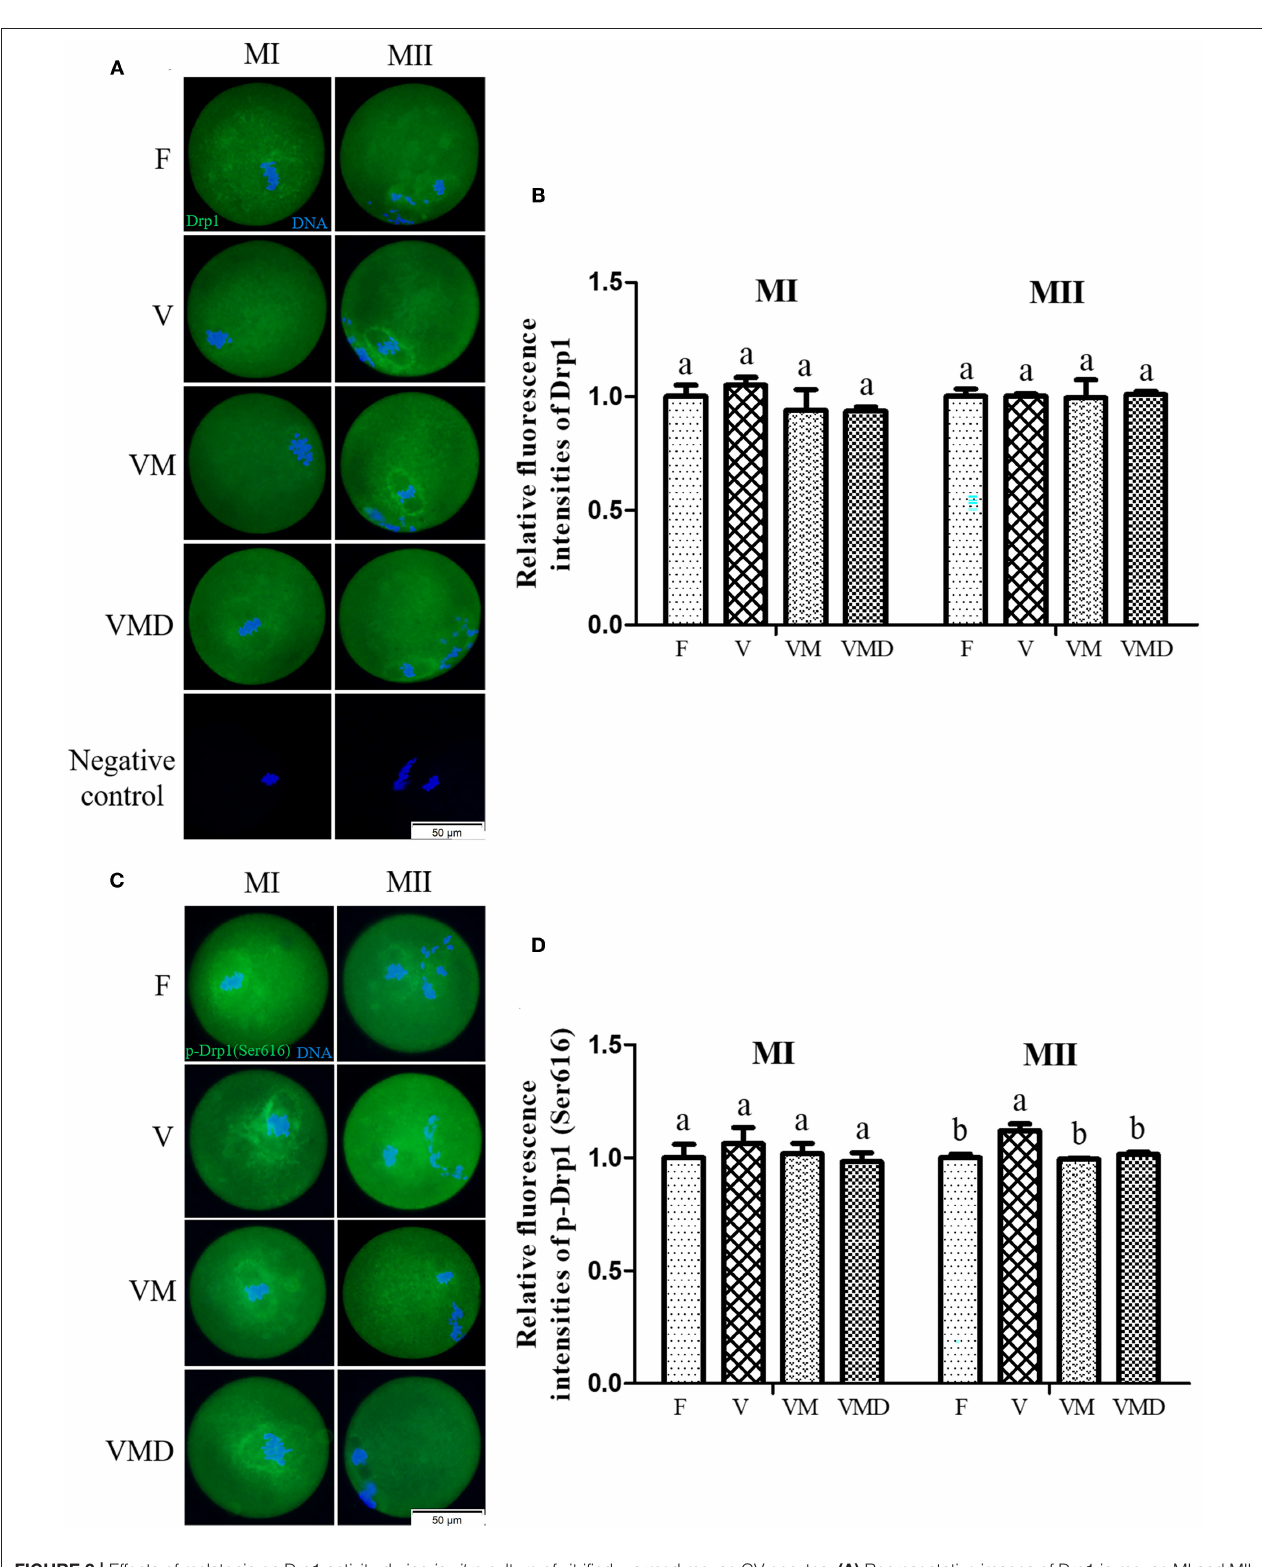
FIGURE 2 | Effects of melatonin on Drp1 activity during in vitro culture of vitrified-warmed mouse GV oocytes. (A) Representative images of Drp1 in mouse MI and MII oocytes. Scale bar, 50 µ m. (B) The fluorescence intensity of Drp1 was recorded using ImageJ software. In total, n = 174 MI oocytes (F: n = 45; V: n = 42; VM: n = 45; VMD: n = 42) and n = 147 MII oocytes (F: n = 39; V: n = 40; VM: n = 35; VMD: n = 33) were used in this assay. (C) Representative images of p-Drp1 (Ser616) in